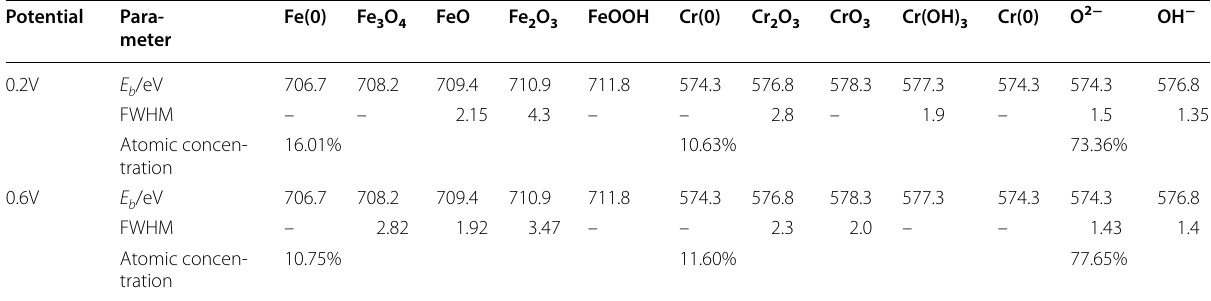
Table 3 Peak positions and fitted results for chromium, iron and oxygen from XPS Potential Para‑ Fe(0) Fe 3 O 4 FeO Fe 2 O 3 OH − meter 0.2V E b /eV FWHM – – Atomic concen- 16.01% tration 0.6V Atomic concen- tration